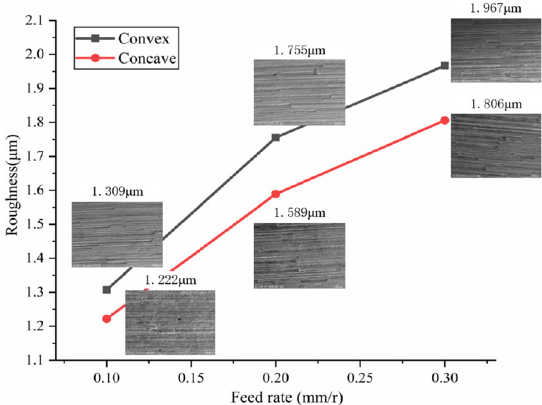
Figure 13 Influence of feed rate on the morphology of machined concave and convex surfaces